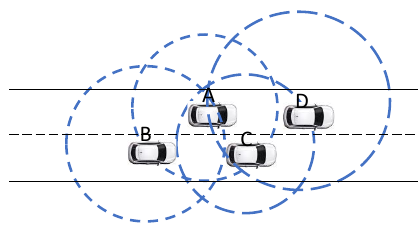
Figure 13. Images of screens when each vehicle overtakes the other.